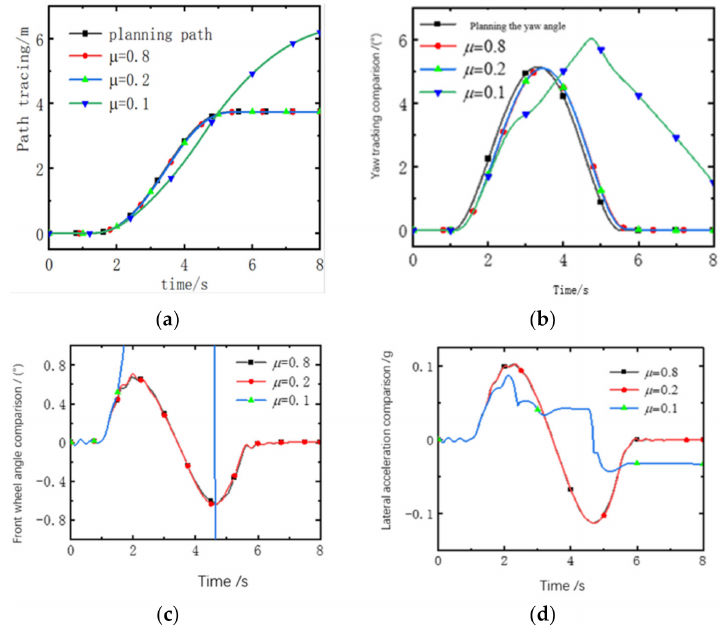
Figure 8. Simulation comparison under different road adhesion coefficient conditions. ( a ) Path tracking. ( b ) Yaw tracking. ( c ) Front-wheel angle. ( d ) Lateral acceleration.